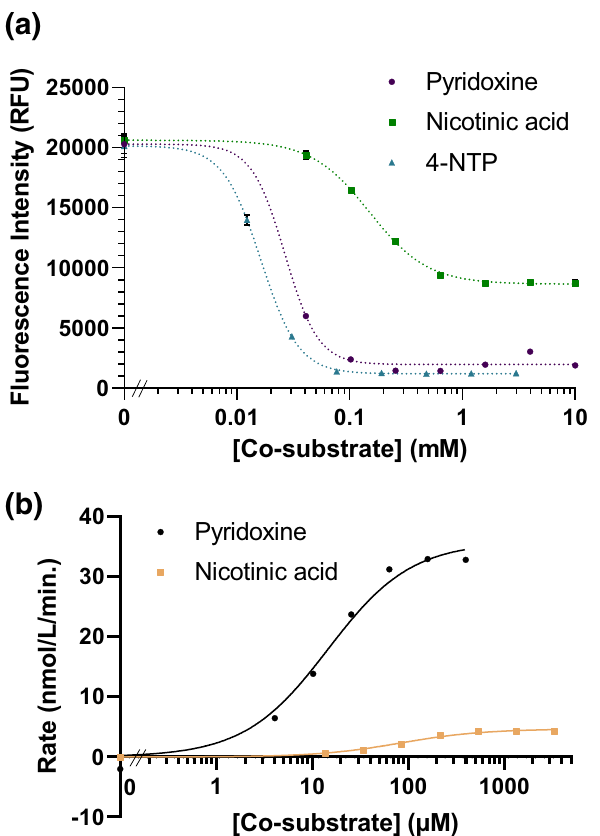
Figure 3. ( a ) Co-substrates for thiaminase I from C. botulinum. 10 µM thiamine, 10 nM–10 mM 4-NTP, nicotinic acid, and pyridoxine in 20 mM MES/20 mM NaCl, pH 6.5 were incubated in the presence of 0.5 µg/ mL thiaminase I at 37 °C for 24 h. 5 µL of the reaction mixture was diluted with 45 µL water, then 100 µL 0.05% potassium ferricyanide in 15% (w/v) sodium hydroxide was added prior to measurement using 360/40 nm excitation, 450/50 nm emission. ( b ) Rates of thiamine loss after 30 min. as a function of pyridoxine and nicotinic acid